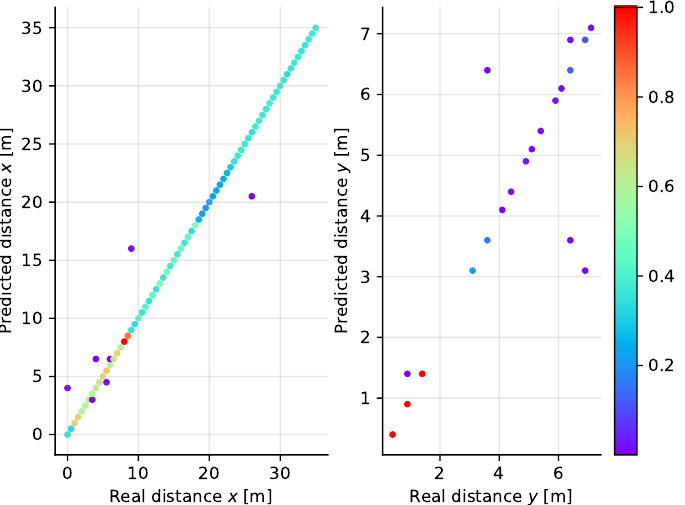
Figure 18. Scatter plot diagram of the real and predicted distance along the X ( left ) and Y ( right ) axes for the Random Forest classifier applied to two-dimensional localization.